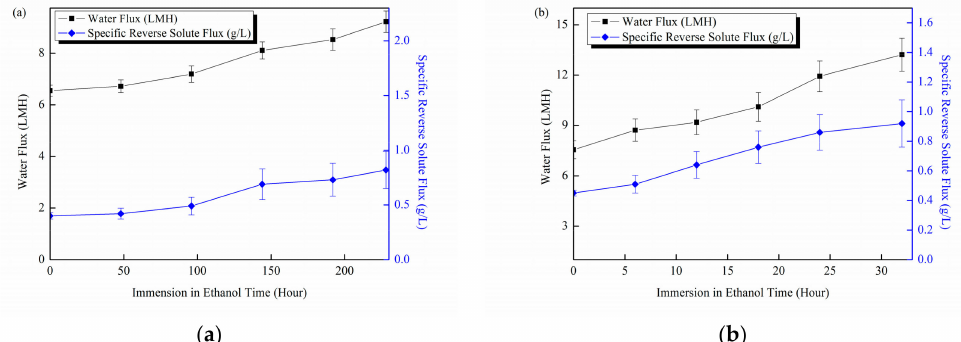
Figure 5. ( a ) The influence of ethanol immersion on the FO performance of M-2 membrane; ( b ) The influence of ethanol immersion on the FO performance of M-0 membrane. The FO performance was tested in active layer-feed solution (AL-FS) mode with 1 M MgCl 2 as draw solution and deionized water (DI) water as the feed